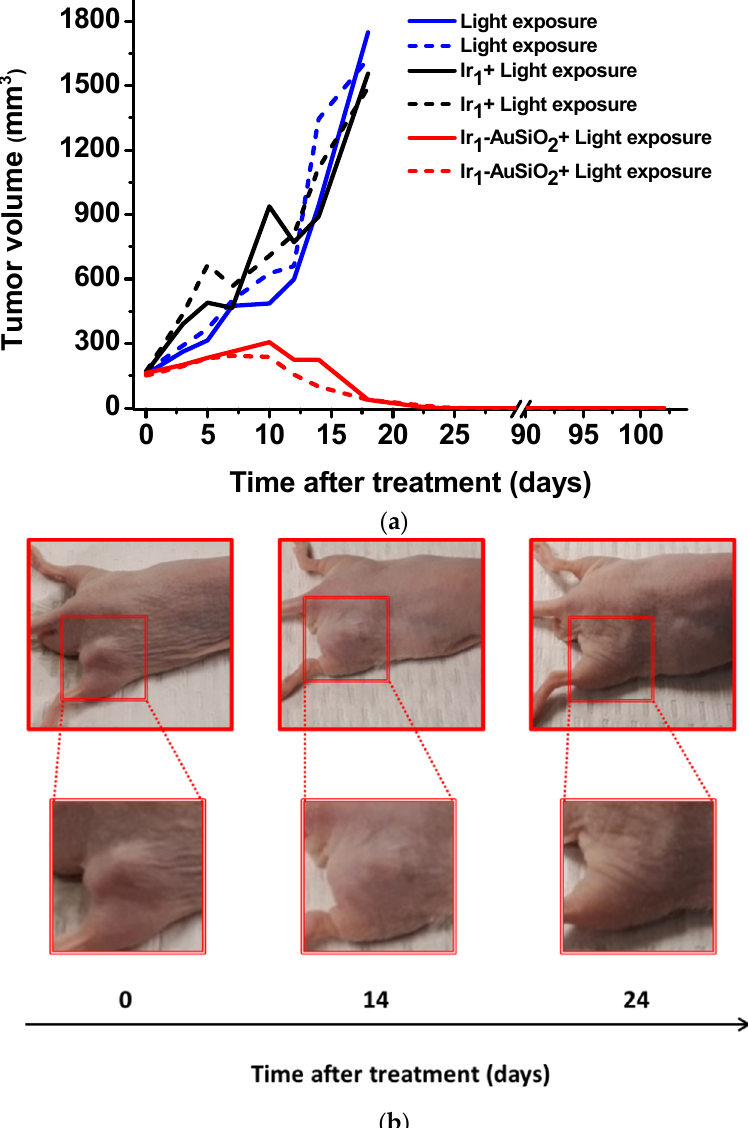
Figure 4. Follow-up of GBM xenografted mice after photo-treatment. ( a ) Time-dependent tumor growth curves after light exposure (control group) or after intratumoral injection of Ir 1 or Ir 1 -AuSiO 2 + light exposure (treatment groups) in GBM-bearing mice ( n = 2 mice per group). Solid or dotted lines were used to better distinguish the tumor growth curves of mice within each group. ( b ) Photographs of a representative mouse from Ir 1 -AuSiO 2 + light exposure group showing the complete post-treatment tumor regression.